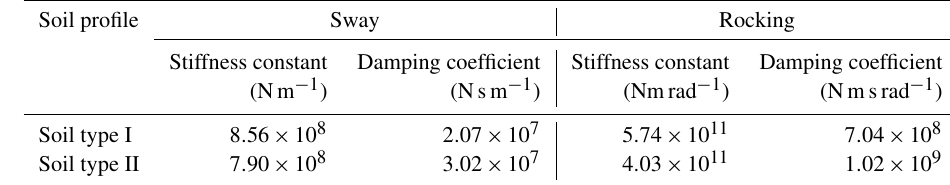
Table 4. Stiffness constants and damping coefficients for the soil–foundation system.